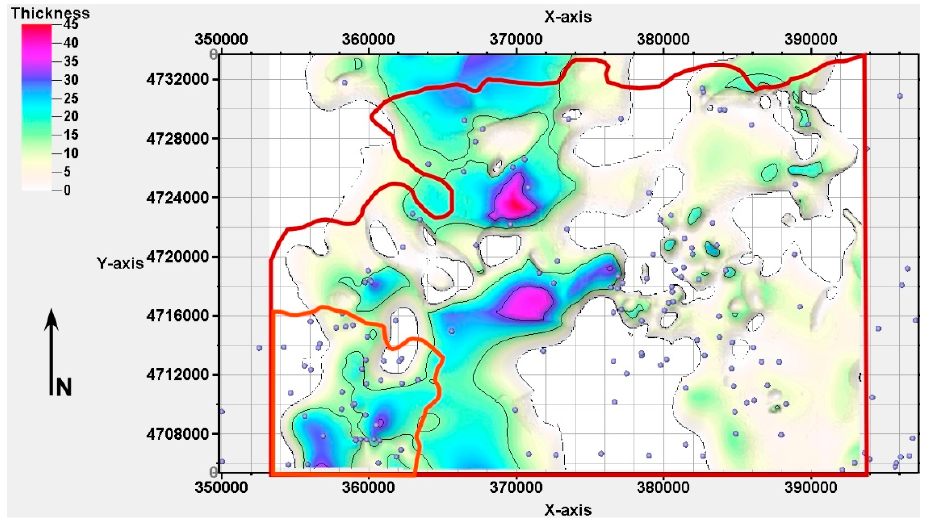
Figure 12. Isopach map of the Sub-Walworth Sand/Gravel. Purple dots represent water-well locations. Thickness is in meters.